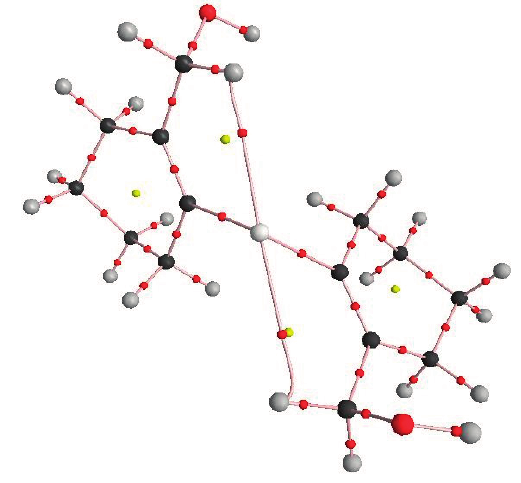
Figure 4. AIM picture of 19 showing bond critical point for C–H···Se